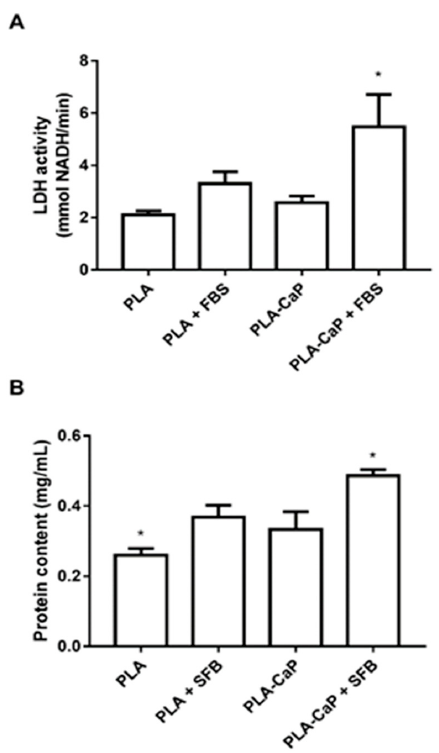
Figure 8. Estimative of the adhered cells to each scaffold, as measured by the release of cytoplasmic lactate dehydrogenase ( A ) or total protein content ( B ), after solubilization with the detergent Triton X-100. Bars indicate the mean and SD of NADH reduction in culture media 25 min after the addition of substrates and solubilizer. The asterisk indicates significant difference from all groups ( p < 0.05, Kruskal-Wallis Test with Dunn post-test).